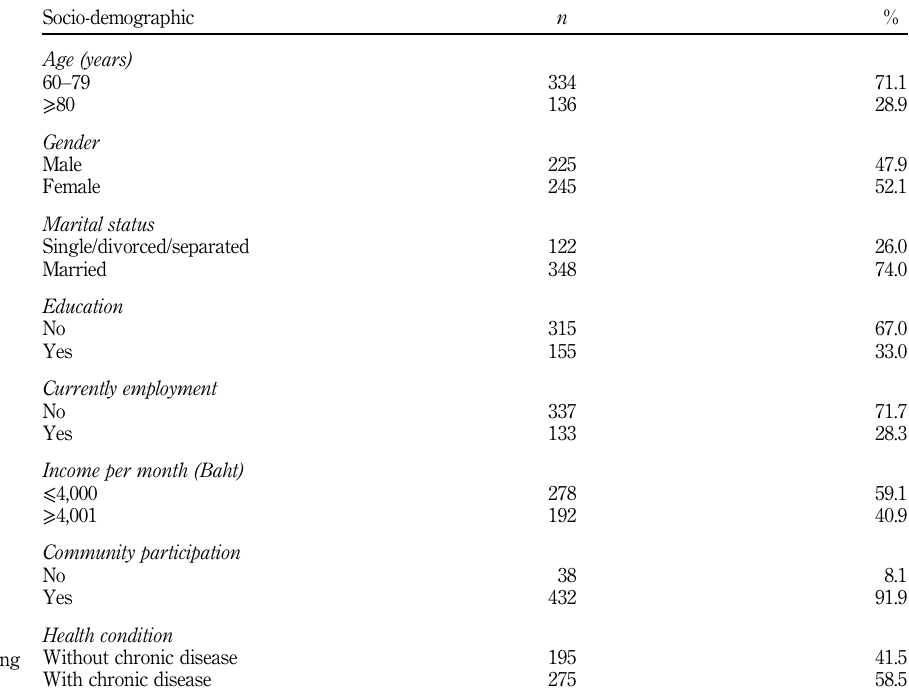
Table I. Socio-demographic characteristics among older